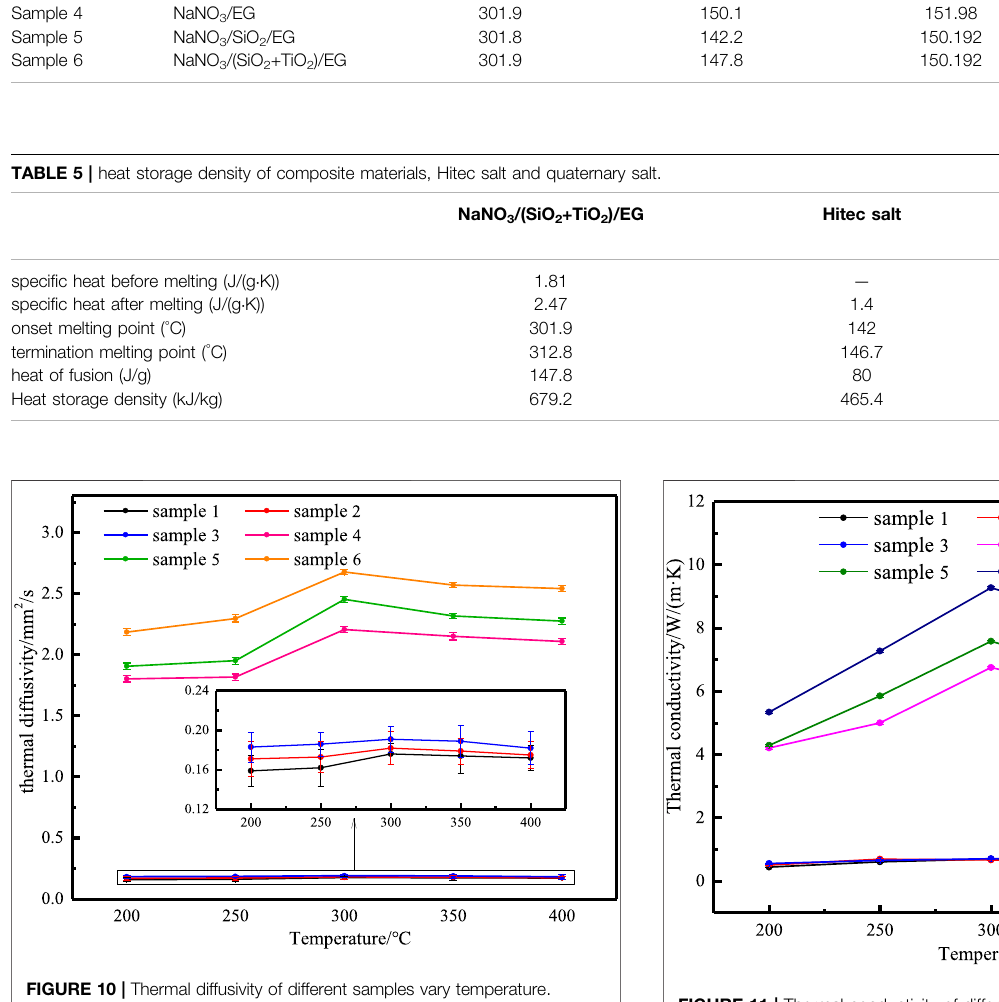
FIGURE 11 | Thermal conductivity of different samples vary